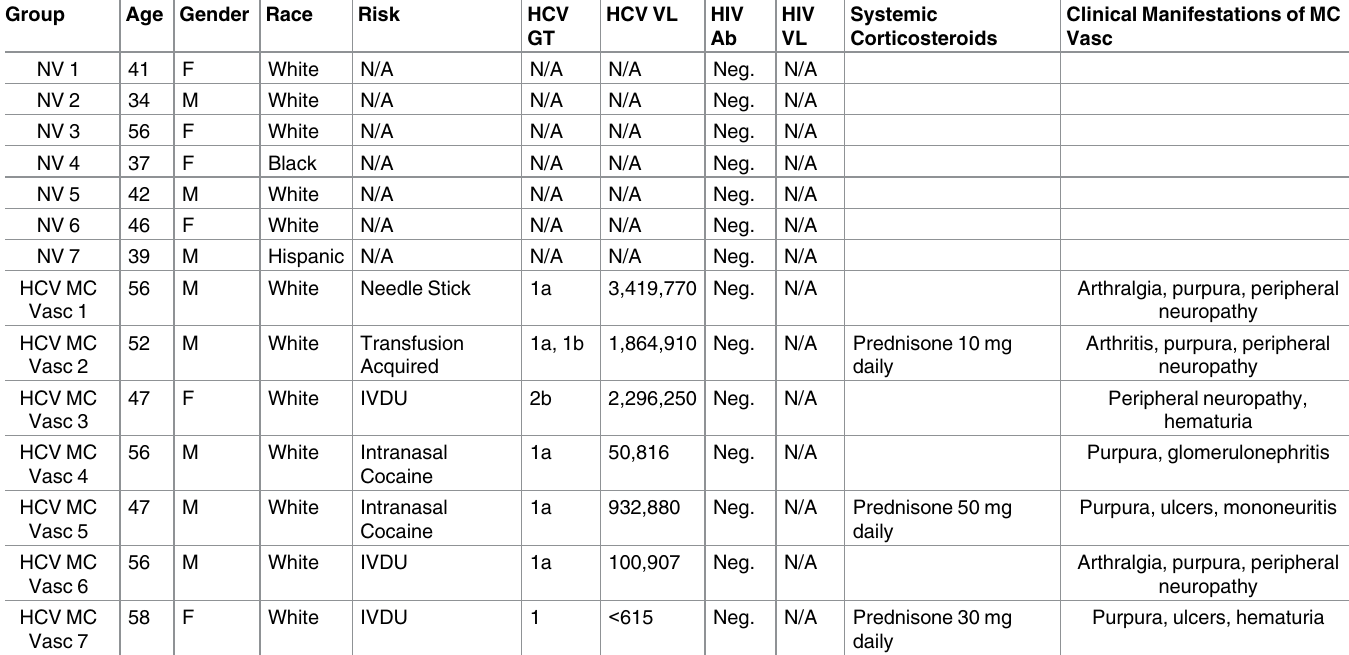
Table 1. Demographics and clinical characteristics of study